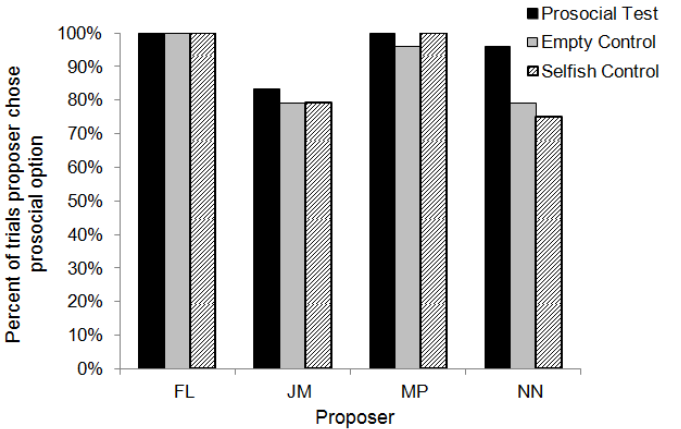
Figure 6. Percent of trials each actor selected the prosocial choice (0/1) when presented with the choice between 0/1 and 0/0 in the three